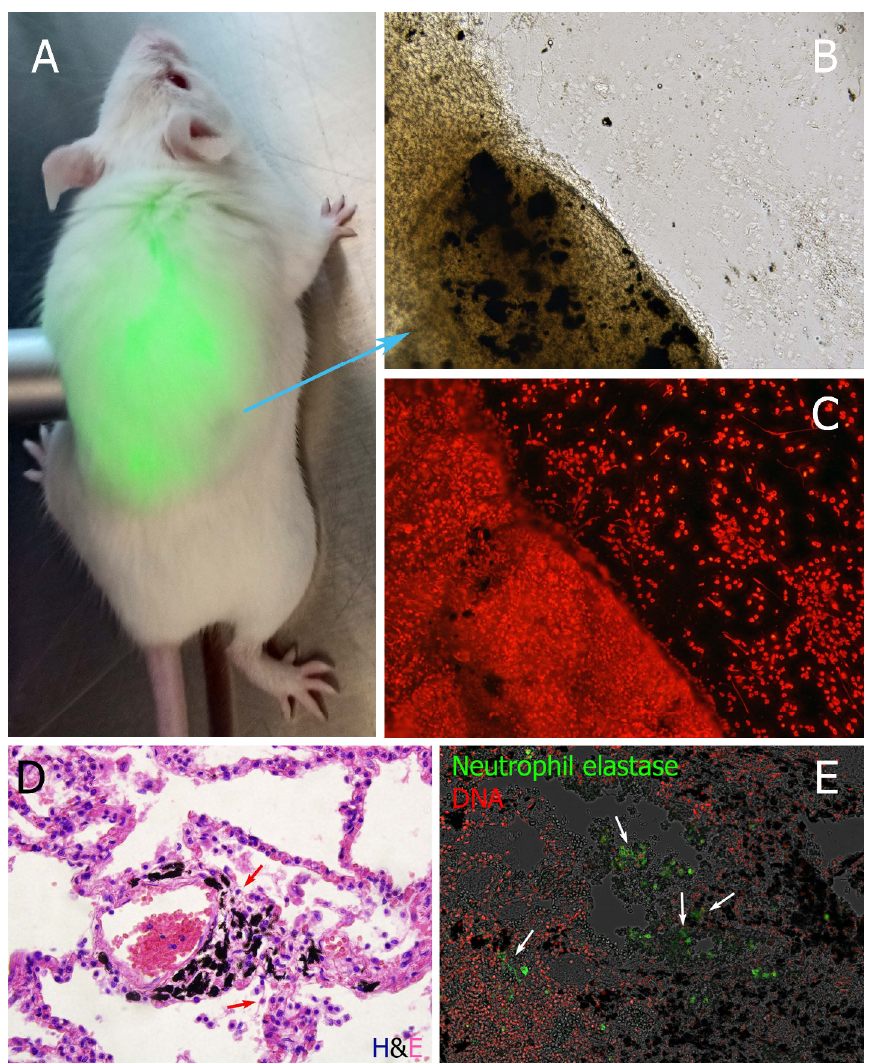
Figure 4. Sequestration of soot n / µ P by NETs. ( A ) mice injected with soot suspension into the air pouch after 24h demonstrate accumulation of all black material in one spot. Histology of this material ( B ) and fluorescence microscopy ( C ) revealed that neutrophils externalized DNA and entrapped the soot, objective: 10 × . ( D) lung tissue of light smoker demonstrating concentration of dust materials in some specific areas of lung tissue. Externalized DNA and neutrophils elastase surrounded these areas ( E ). ( D , E ) objective is 40 × 0.75NA.